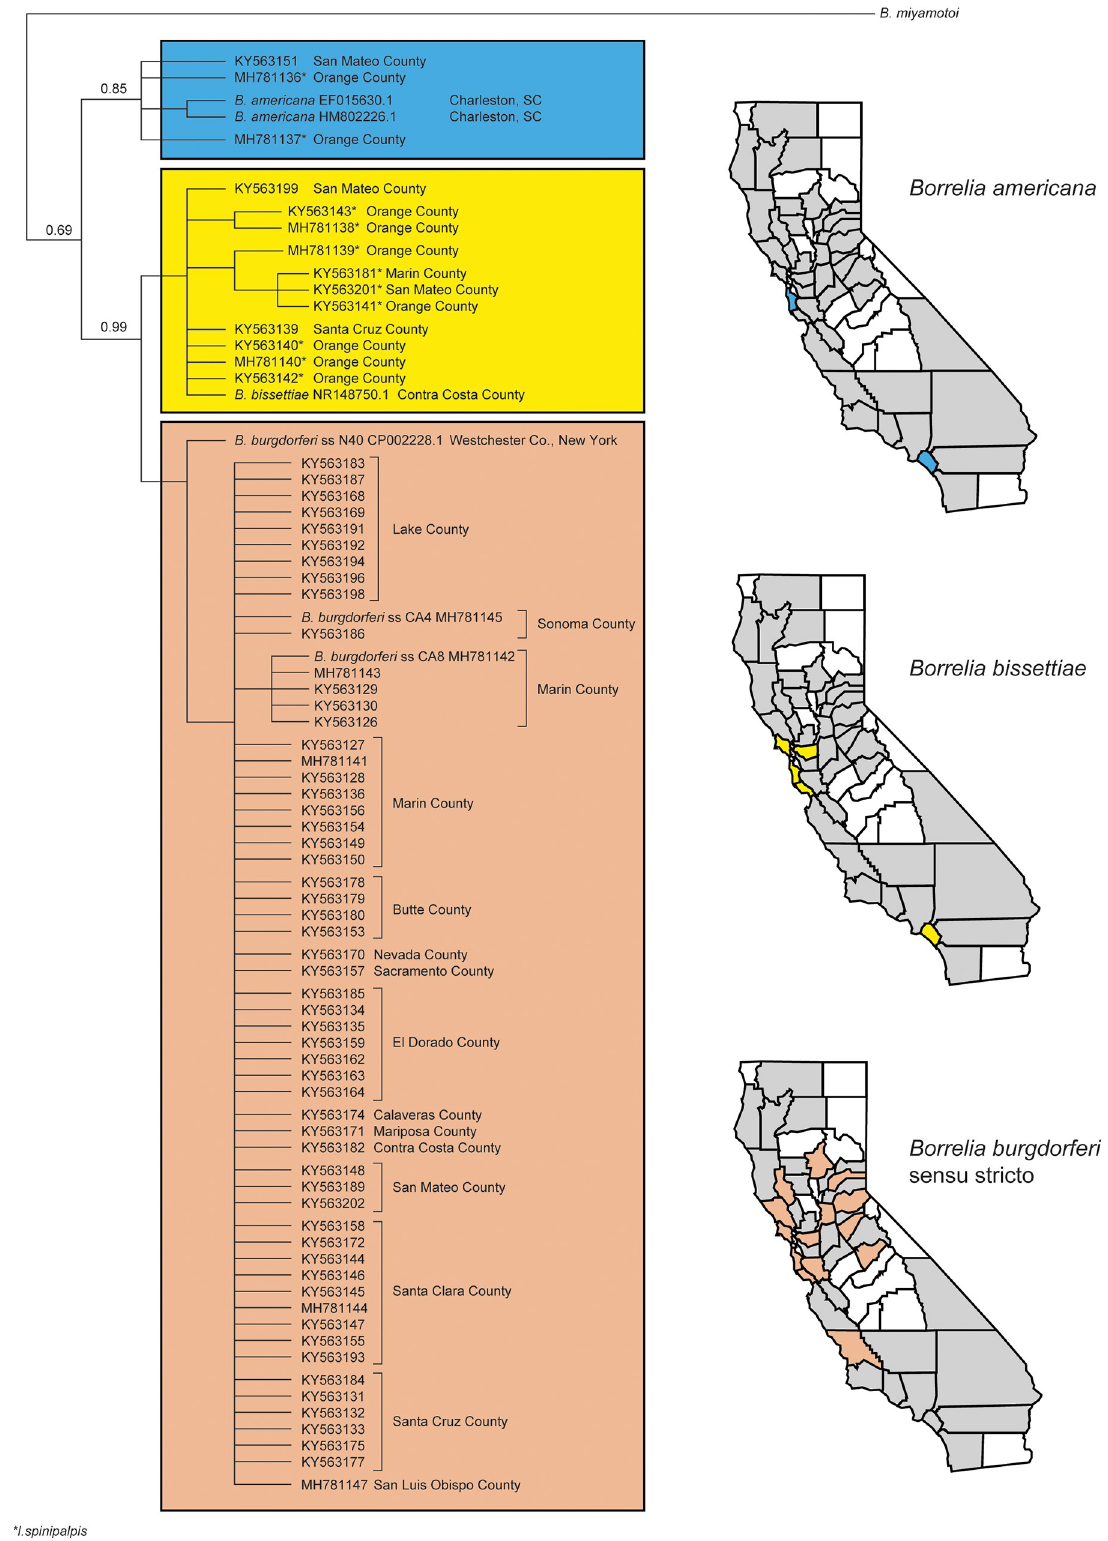
Fig 1. Borrelia genospecies detected in Ixodes pacificus and Ixodes spinipalpis ticks in California counties, 2008–2015.